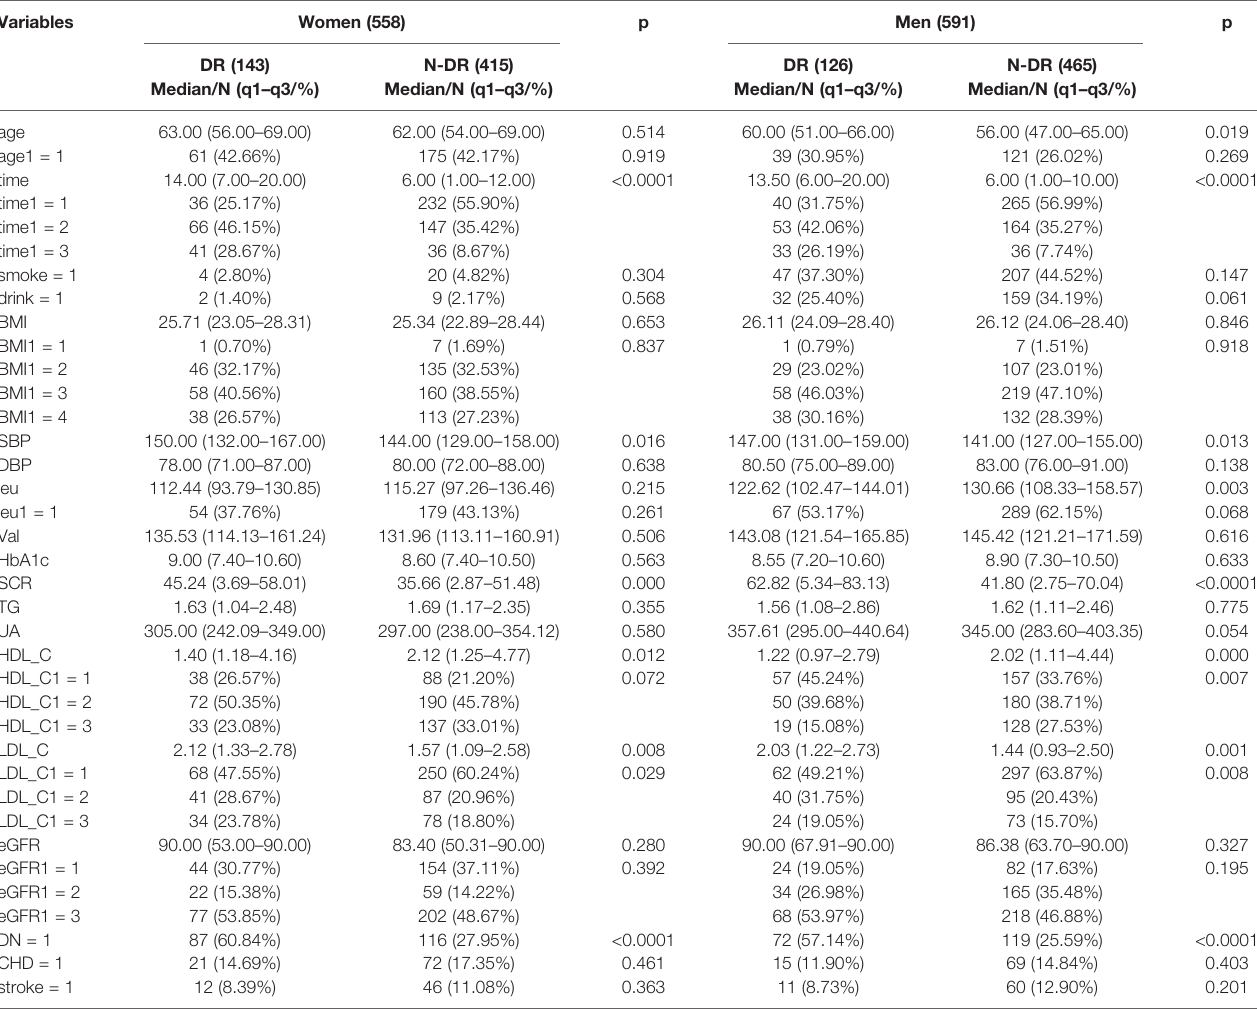
TABLE 1 | Difference analysis of related indicators of DR after gender strati fi